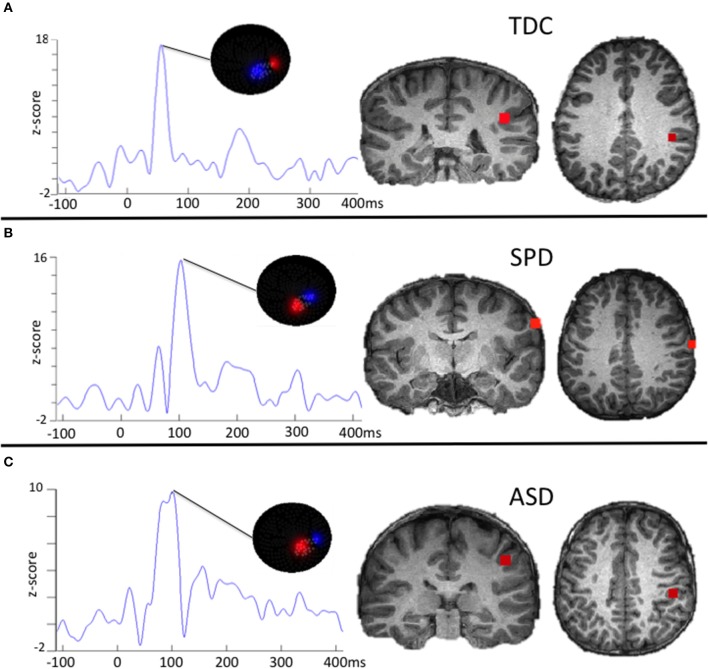
Examples of somatosensory evoked fields source localizations and corresponding waveforms with flux topography. The waveform amplitude is normalized within subject on the y axis, which represents the z-score of the source waveform amplitude based on the pre-stimulus baseline (originally measured in fT). The timescale on the horizontal axis is in milliseconds. For (A), the flux topography identifies the Somatosensory (SS) peak that roughly corresponds to the expected latency in TDC participants. For (B), the SPD participant demonstrates a delayed SS latency that does not meet a stringent significance threshold relative to the TDC or ASD cohort. For (C), the ASD participant demonstrates a delayed SS response that is characteristic for the group as a whole.